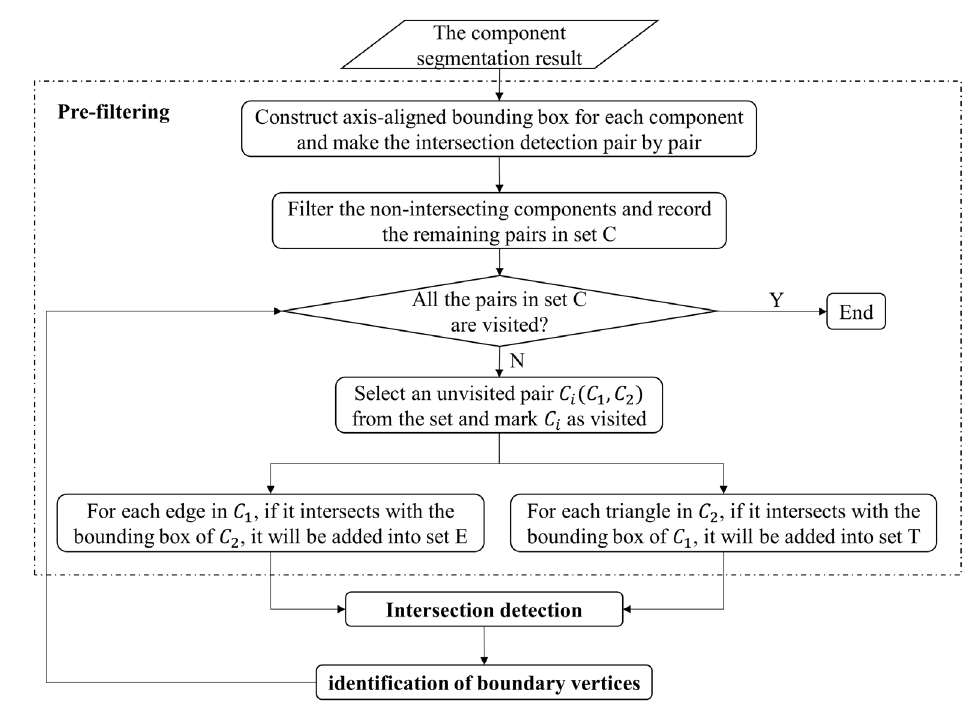
Figure 7. Flowchart of extraction for boundary vertices.